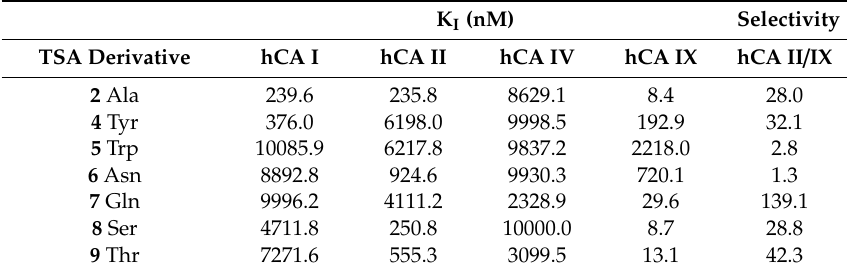
Table 4. Predicted inhibitory values for new sulfonamide derivatives disubstituted with proteinogenic amino acids possessing polar neutral and hydrophobic side chains.